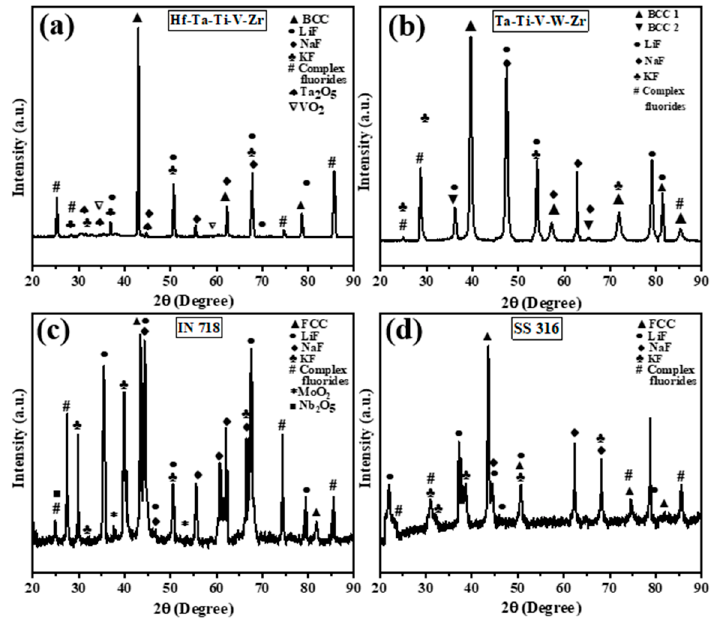
Figure 7. The XRD spectra obtained from the surface of ( a ) HfTaTiVZr, ( b ) TaTiVWZr, ( c ) IN718, and ( d ) SS316 alloys after immersion test in molten FLiNaK salt at a temperature of 650 °C for a duration of 60 h.